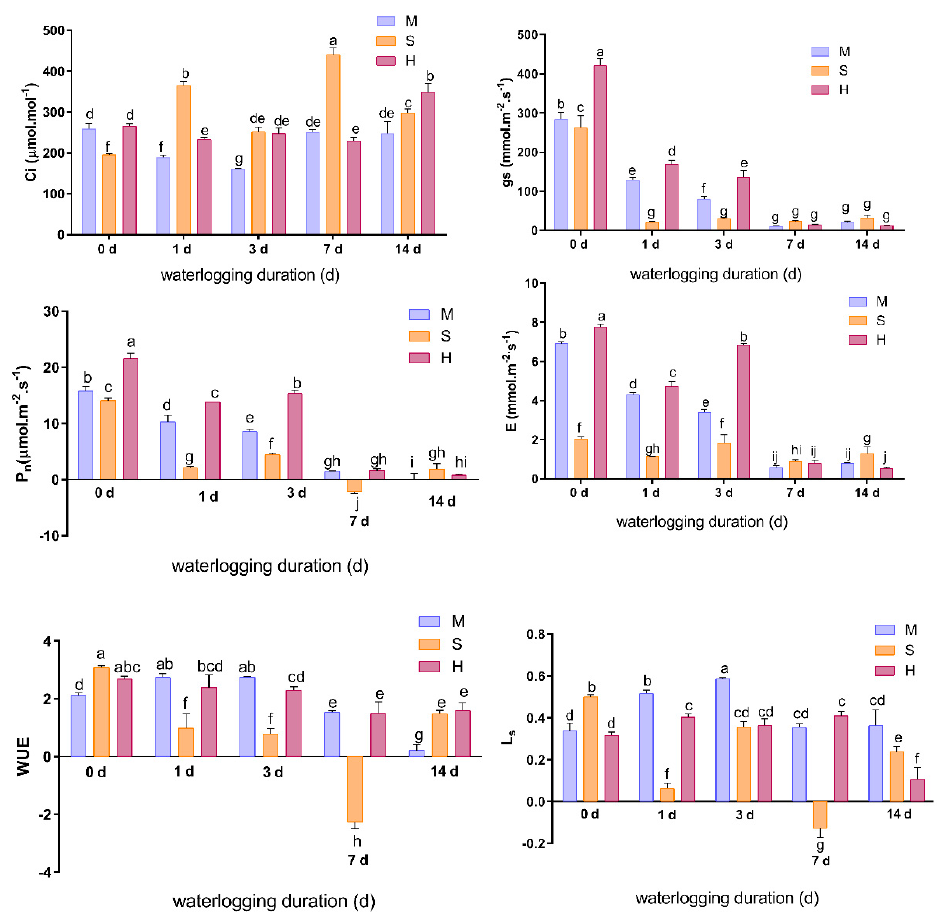
Figure 3. The photosynthetic parameters of leaves of different peach rootstocks under waterlogging treatment. Abbreviations: M: Prunus persica, ‘Maotao’; S: Prunus davidiana, ‘Shantao’; H: ‘Hossu’. The data are the means ± SDs. Within columns, means with a different letter indicate significant differences ( p < 0.05) using Duncan’s test; bars on the columns represent the standard errors (SD) (n = 6).